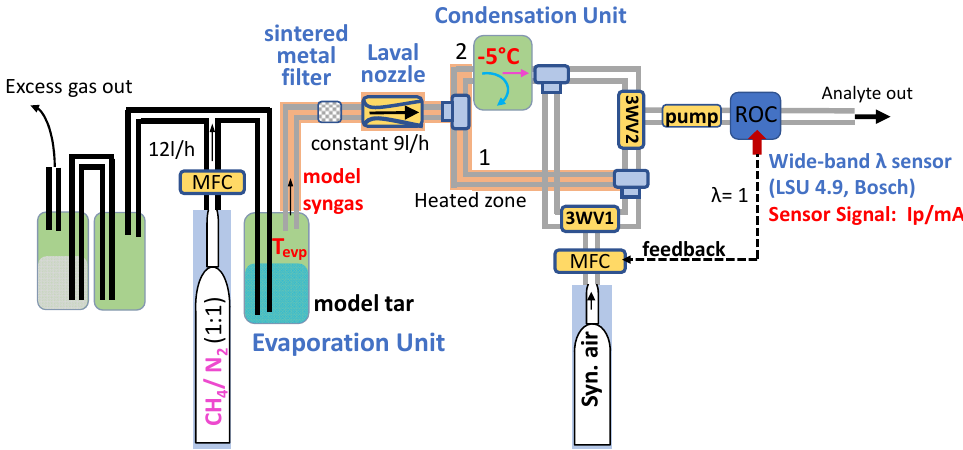
Figure 3. Laboratory version of the experimental setup of the TAR monitoring system for the continuous extraction of the constant hot syngas flow. The syngas was simulated by an excess flow of a CH 4 /N 2 -mixture (model syngas). The heated zone (300 °C) is indicated.